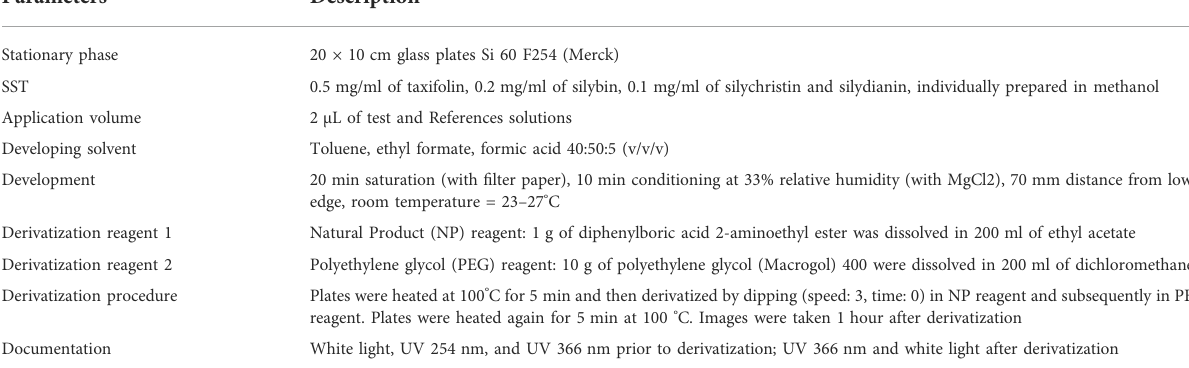
TABLE 1 HPTLC parameters for identi fi cation of milk thistle.